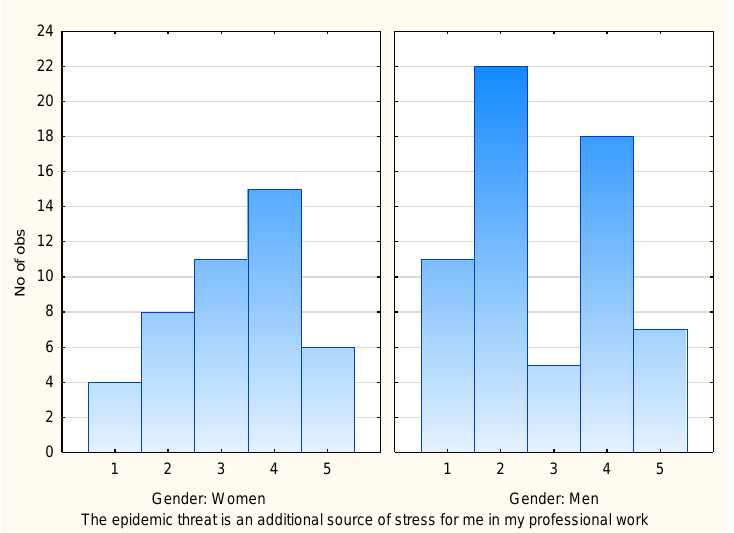
Figure 3. Distribution of respondents’ answers about experiencing stress due to the COVID-19 pandemic (by gender).